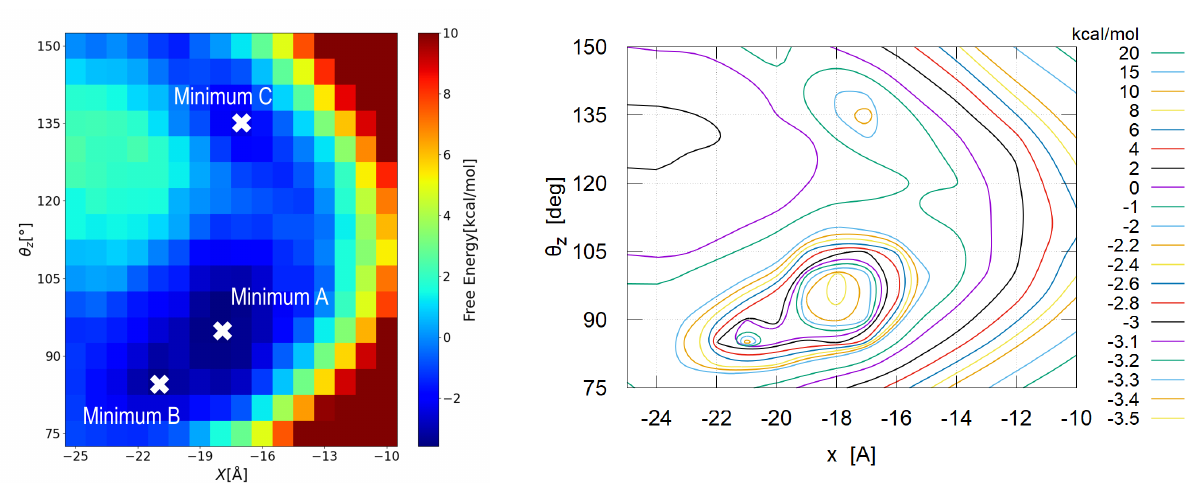
Figure 6. Adsorption free energy on finer grid; ( Left ) contour color map indicating three local minima, ( Right ) contour line map for the same data. The contour lines are drawn with eighth-order B-spline